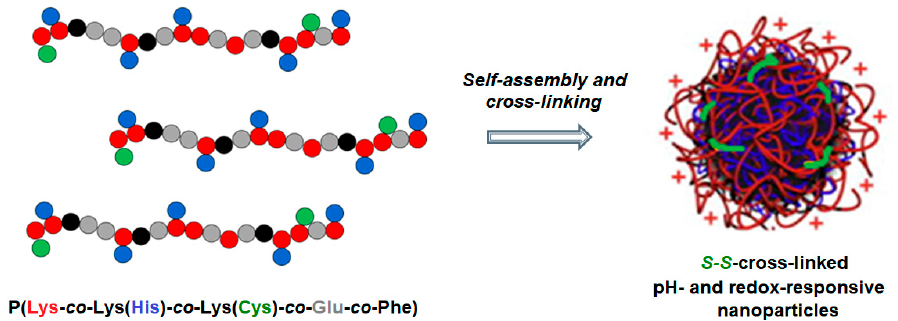
Figure 1. pH- and redox-responsive nanoparticles designed for delivery of nucleic acids.